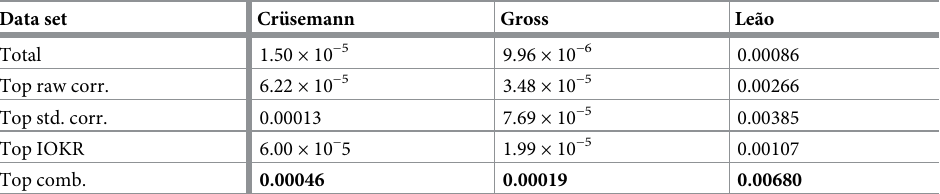
Table 2. Proportion of validated links among all possible GCF-MF links in the three data sets. Data